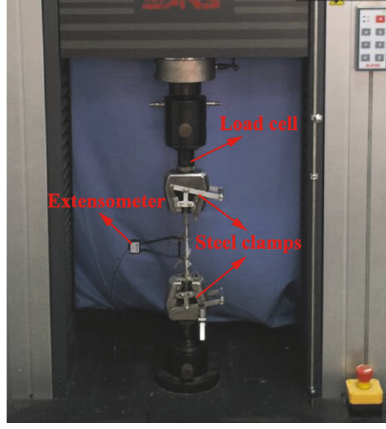
Figure 2: Tensile test set-up. Table 1: Mechanical properties of GFRP under WD